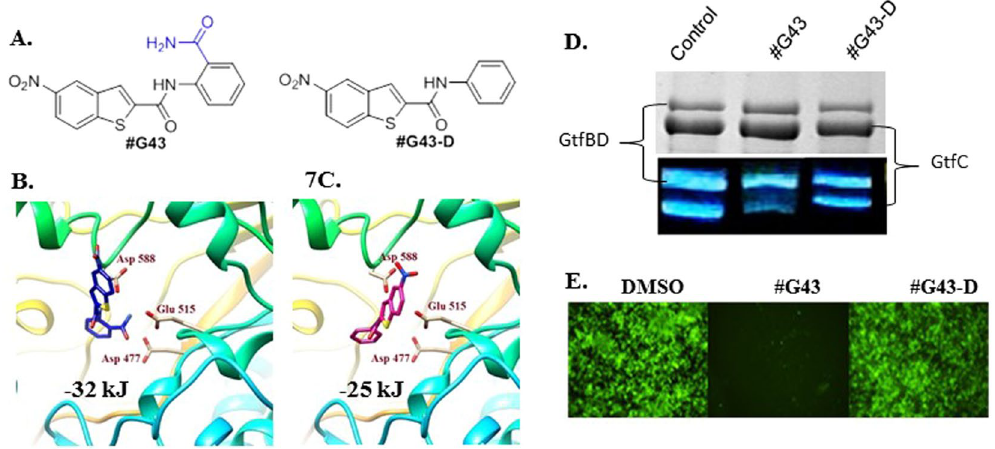
Figure 7. Effects of the lead compound #G43 and its inactive analog #G43-D. ( A ) Chemical structures of lead and its inactive analog. Docking poses of ( B ) Compound #G43 in blue skeleton and ( C ) compound #G43-D in pink skeleton. Three key residue interactions are depicted by displaying residue chains. ( D ) Effects of active and inactive compound on the activity of Gtfs by zymographic assays. Glucan zymographic assays (bottom panel) were performed using SDS-PAGE analysis of Gtfs from culture supernatants of S. mutans UA159 incubated with vehicle control DMSO, the synthesized active #G43, and its derivative at 50 µ M. SDS-PAGE analysis of Gtfs (top panel) was used as a loading control. ( E ) Fluorescent microscopy images of S. mutans UA159 biofilms treated with DMSO control, the synthesized #G43, and its derivative #G43-D at 100 µ M. Viable bacterial cells were stained with 2.5 µ M Syto9